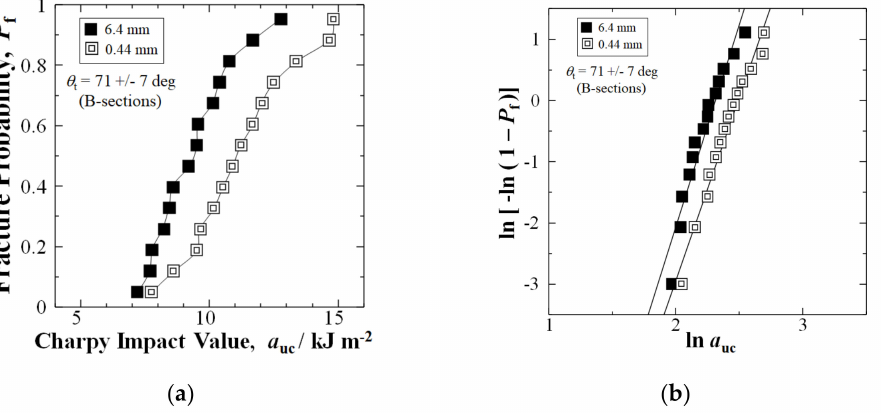
Figure 7. ( a ) Relationship between auc and Pf for nominal 6.4 mm and extended mixed 0.44 mm fiber samples, respectively, for B-Sections with θ t of random (45) 0 to 90 deg between mold flow and longitudinal direction of testing sample; ( b ) Weibull 2-parameter plots of data in ( a ).